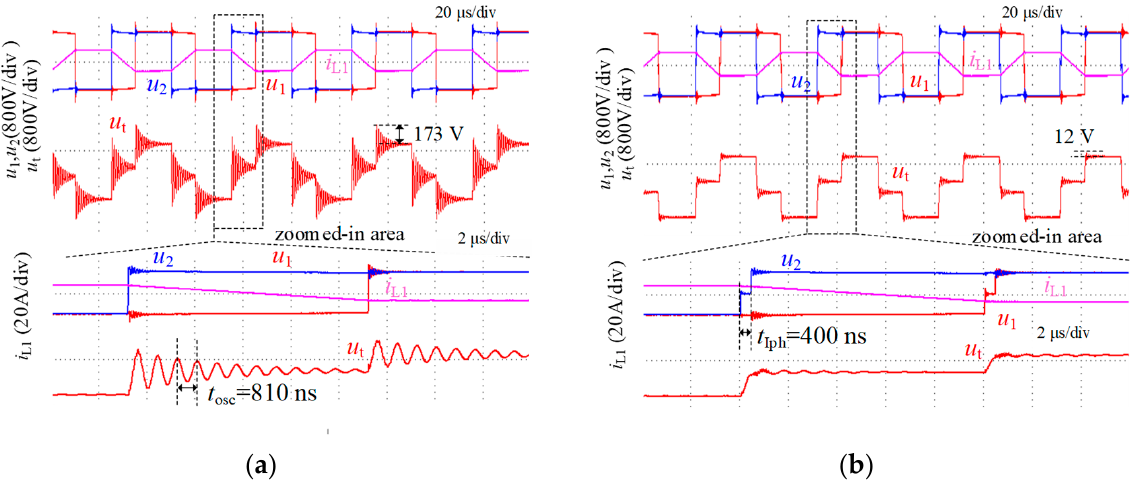
Figure 12. Waveforms of the DAB converter with forward power flow ( D = 0.4): ( a ) no suppression; ( b ) with the SHE PS method.